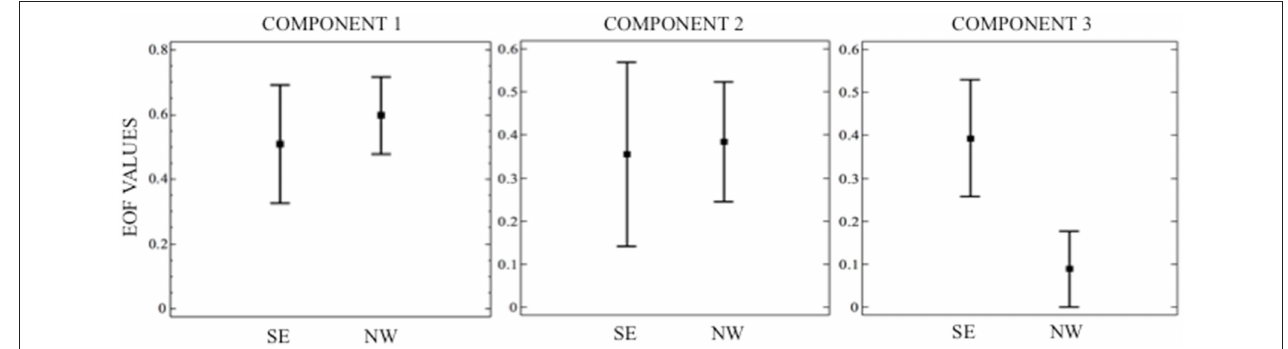
FIGURE 7 | Box-plot of EOF values for PCs in function of surface wind direction, SE, and